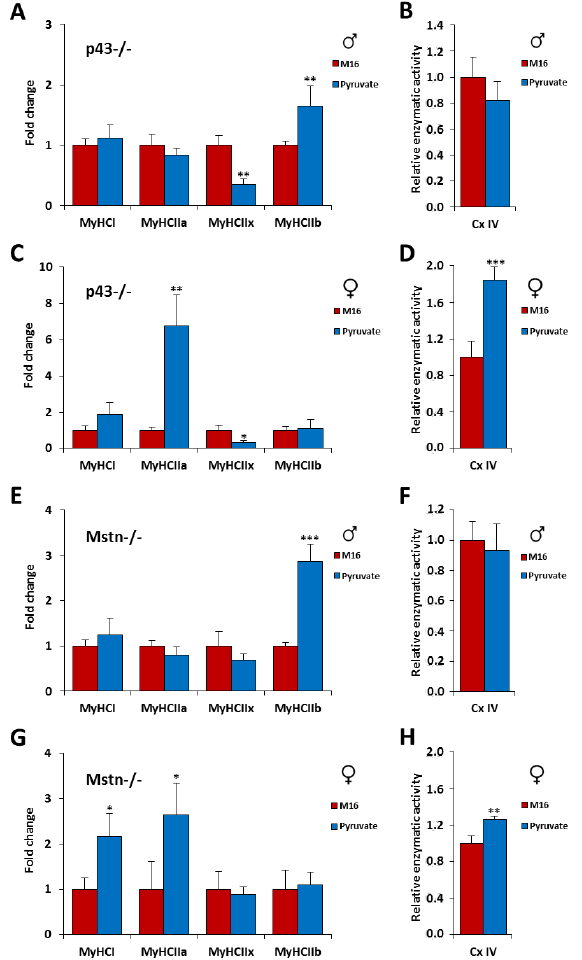
Figure 6. Short exposure in M16 / pyruvate medium at 1 cell embryo stage also alters contractile